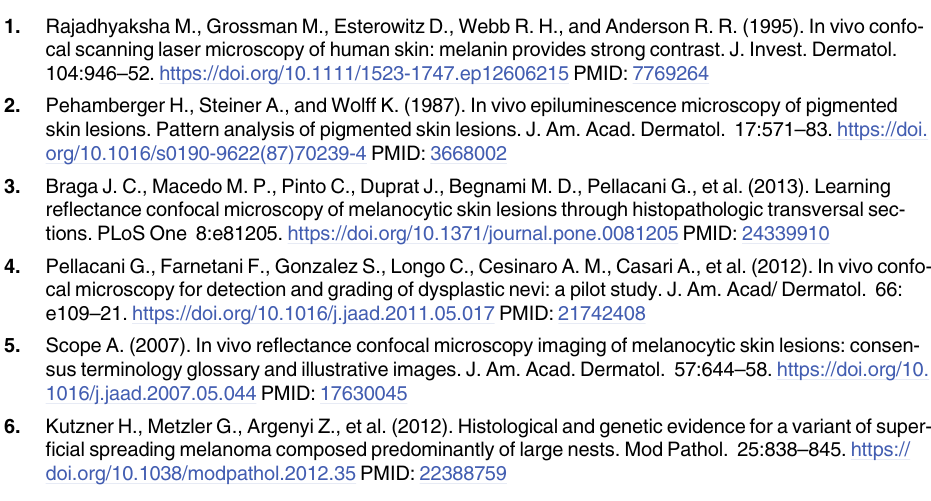
S1 Table. Dermoscopy features of all lesions included at the study. S2 Table. Confocal microscopy features of all lesions included at the